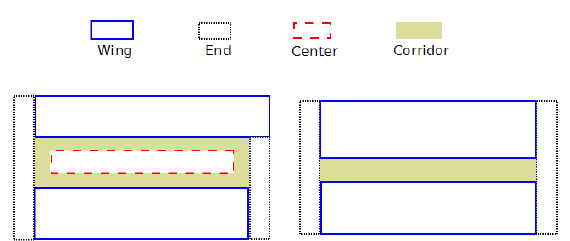
Figure 9. Three types of distribution